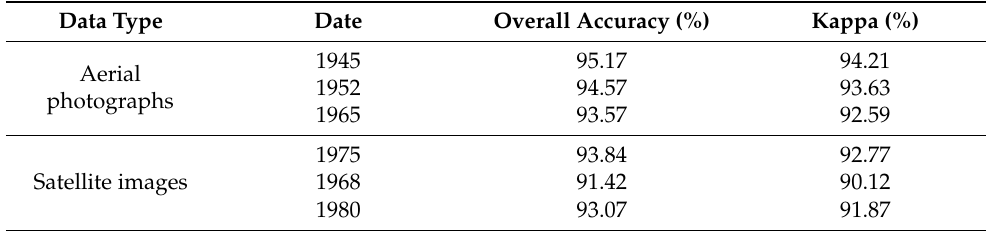
Table 5. The overall accuracy and Kappa statistics of land cover maps of